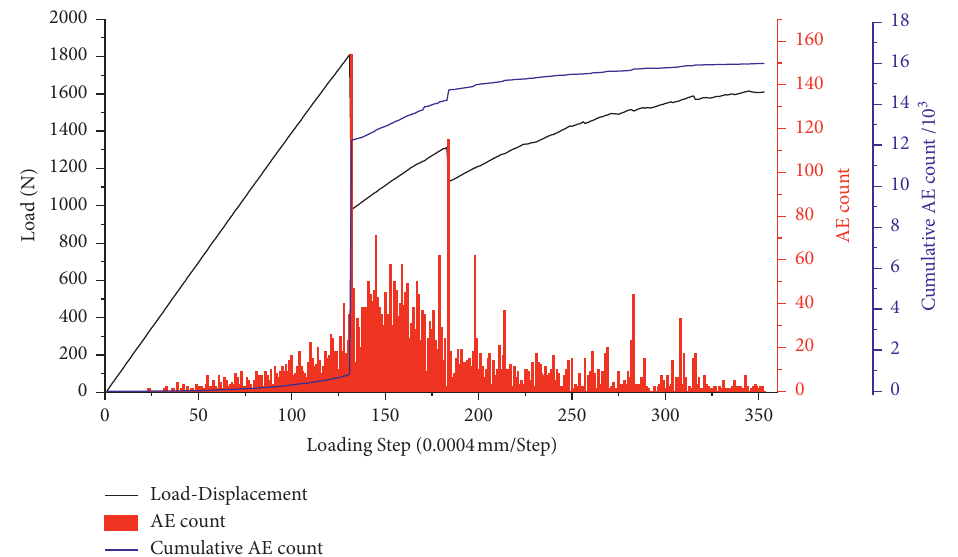
Figure 9: Load-AE and cumulative AE displacement curves of a particle under diametral loading without